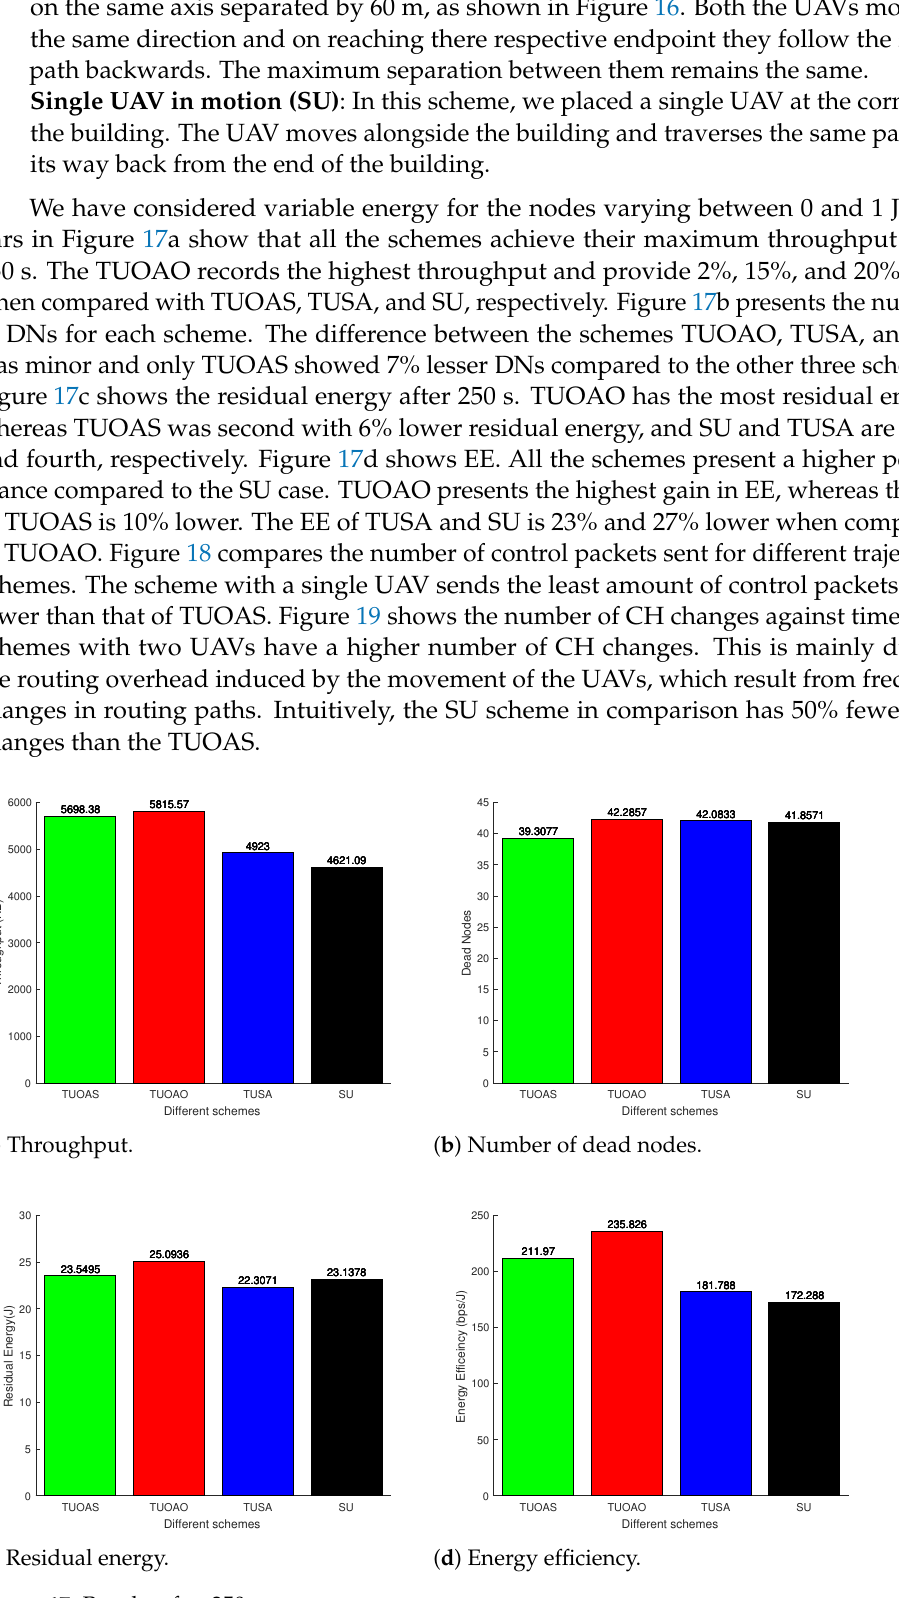
Figure 17. Results after 250